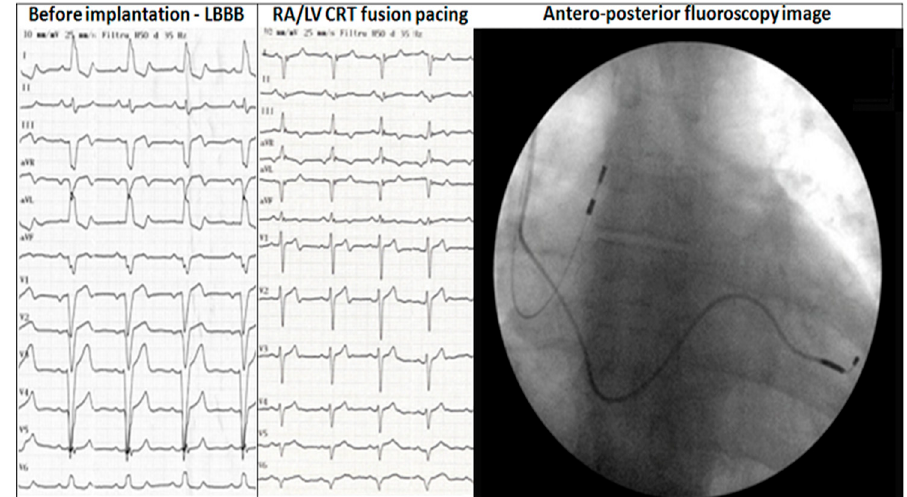
Figure 2. RA/LV DDD CRT in a 7 year follow up patient. ECG before and after cardiac resynchronization therapy: left bundle branch block (LBBB) pattern before implantation and antero-posterior fluoroscopy image; narrow QRS after implantation with negative QRS waves in DI, aVL, negative QRS waves in V6 and rS pattern in V1. Table 2. Baseline echocardiographic parameters.